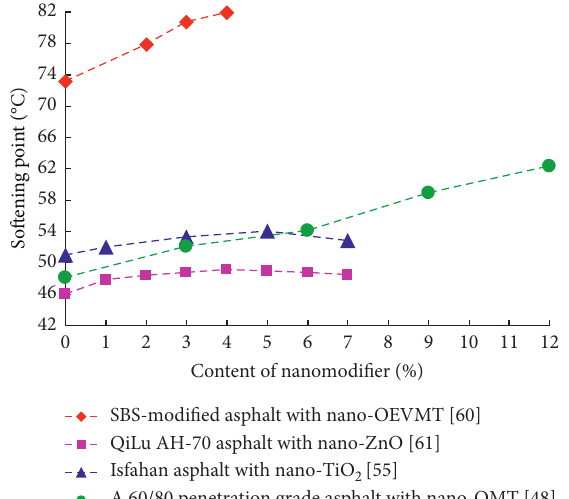
Figure 9: Softening point and nanomodifier content.